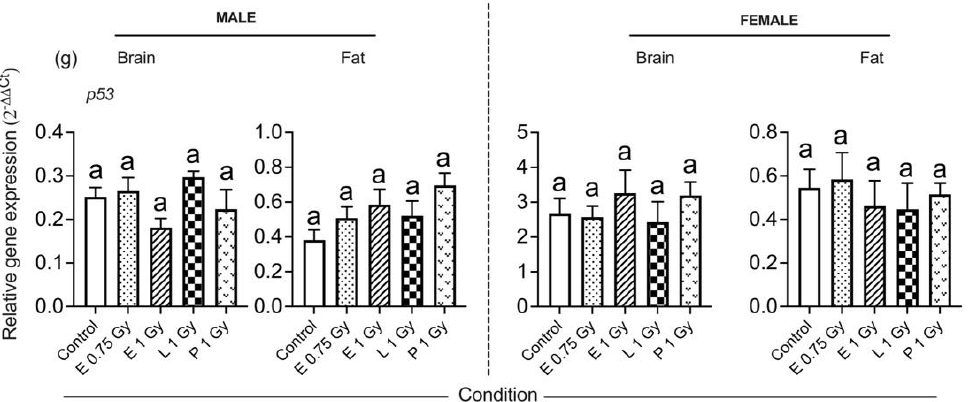
Figure 3. Profile of differentially expressed genes in adult male and female moths, Spodoptera litura, due to potential hormetic doses given in different ontogenetic stages. Genes include: ( a ) foxo, ( b ) sirtuin 2 like/sirt1, ( c ) atm, ( d ) atg8, ( e ) sod, ( f ) cat and ( g ) p53. Mean bars represented by the same letters for a specific gene expression in a particular tissue (brain or fat) of a specific sex (male or female) are not significantly different at p < 0.05. One- way ANOVA followed by Tukey’s multiple